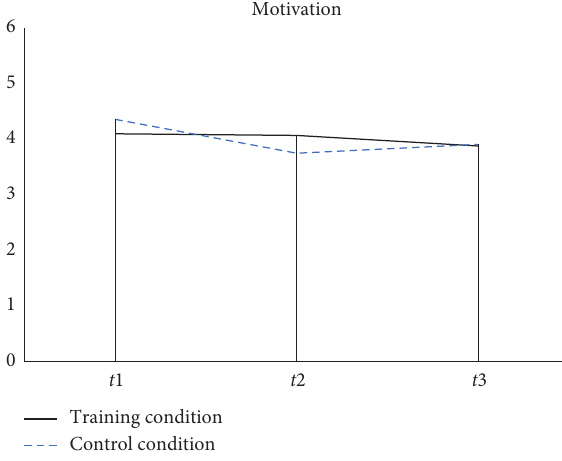
Figure 4: Development of motivation in both